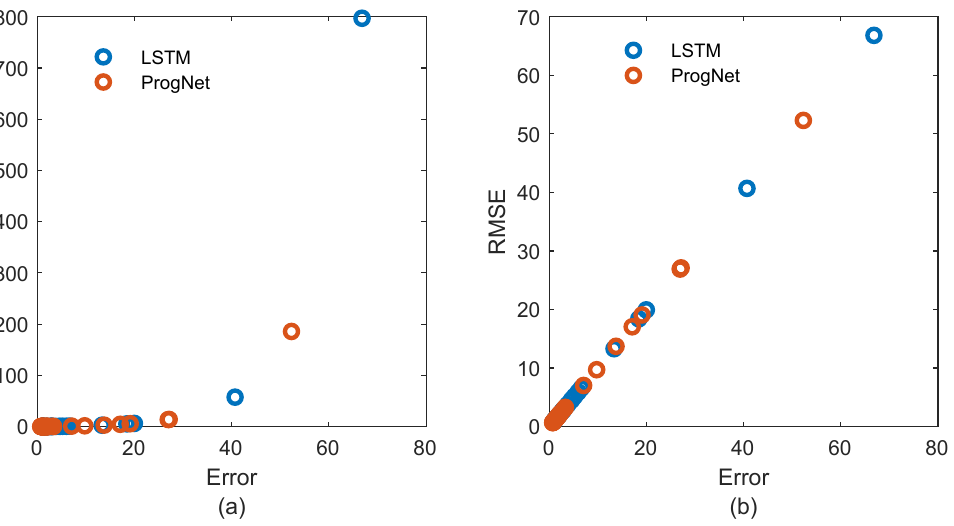
Figure 8. Scoring functions behavior: ( a ) Score function behavior; ( b ): RMSE function behavior.